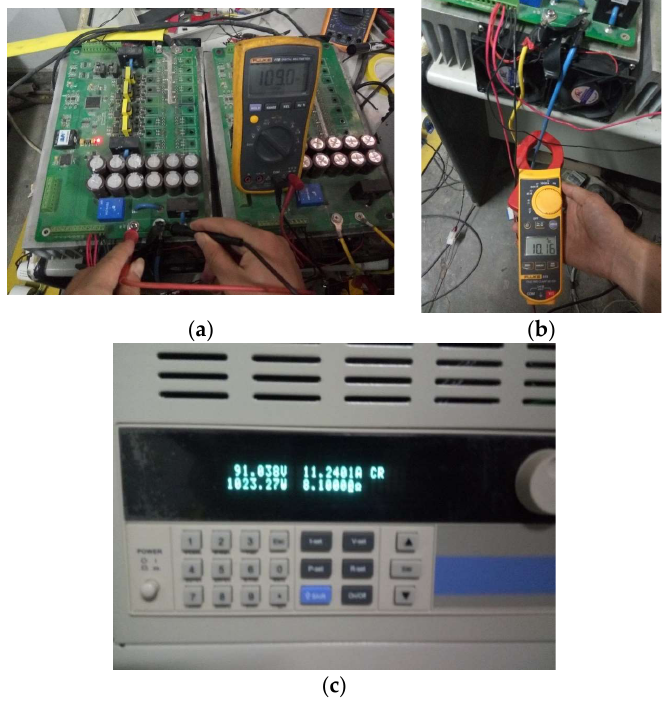
Figure 16. Picture of measuring data of wireless power transfer system with load adaptive control. ( a